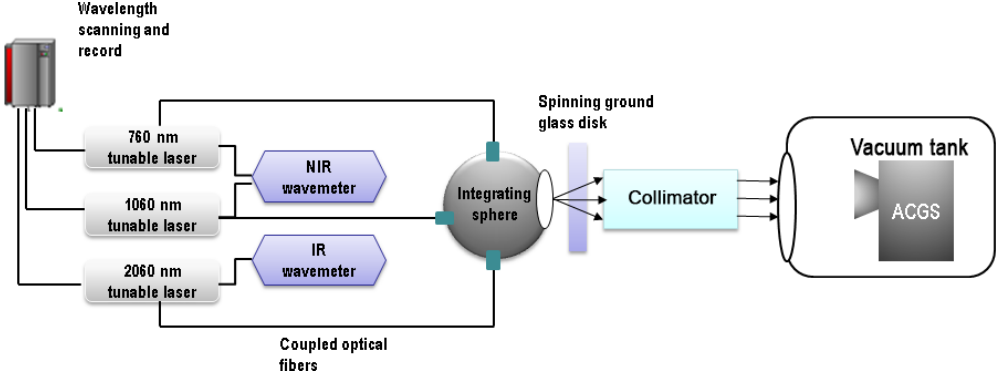
Figure 1. Schematic diagram of the ACGS spectral calibration.